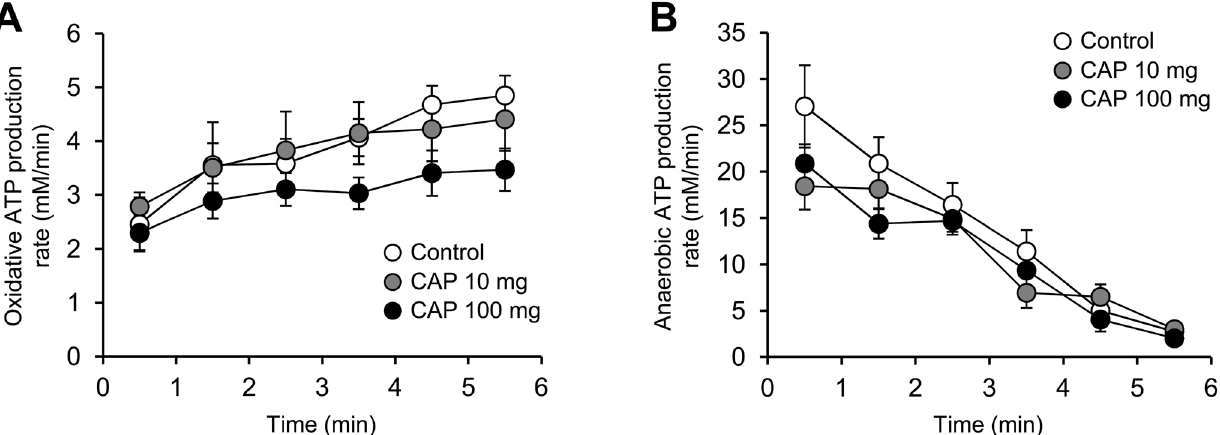
Fig 3. Oxidative and anaerobic ATP productions in contracting mouse gastrocnemius muscle in vivo. Effect of 2-week treatment with vehicle (control) or capsiate (CAP) at two different concentrations (10- or 100-mg/kg body weight) on the time-course of oxidative (A) and anaerobic (B) ATP production rates calculated from in vivo 31 P-MR spectroscopy data throughout the 6-min fatiguing electrostimulation protocol. Data are means ± SEM. * Significantly different (one-way ANOVA; P < 0.05) from control.